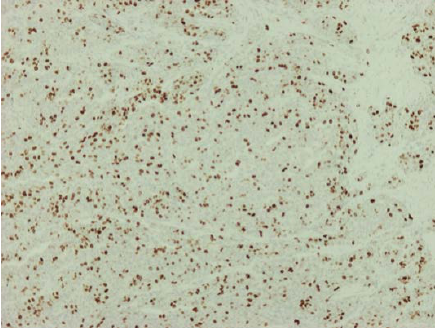
Figure 5. Ki67/MIB1, 10×.